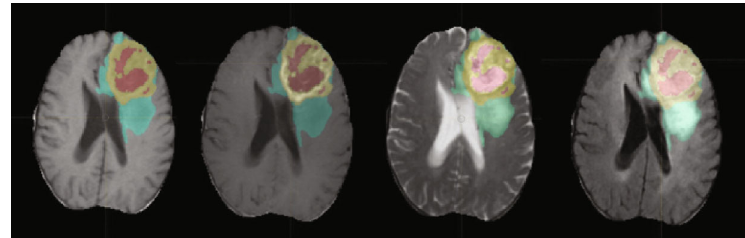
Figure 2: The segmentation result of tumour subregions overlapped on T1WI, CE-T1WI, T2WI, and FLAIR